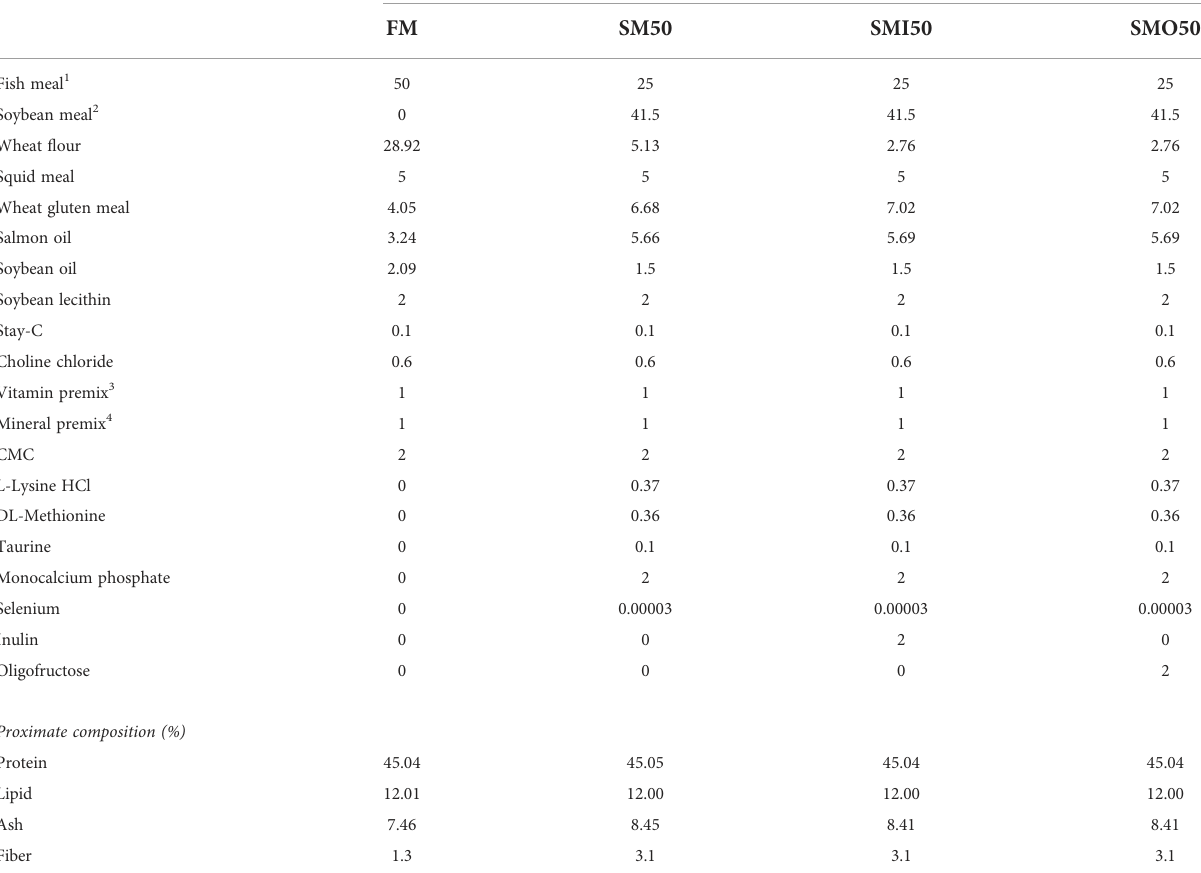
TABLE 1 Formulation and proximate composition of the experimental diets (% dry matter).